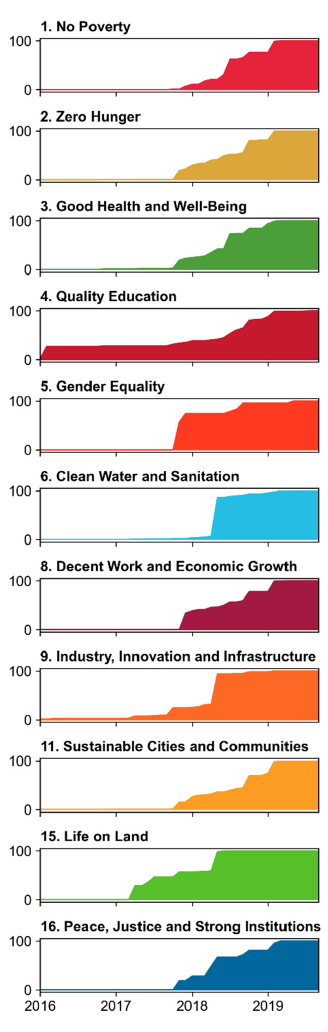
Figure 10. Cumulative timelines of V1 data creation dates across all 21,950 SDG-relevant OSM features. OSM data on SDG 5 (Gender Equality) were the most frequently edited, with a me- dian of six versions per feature compared to the typical median terminal version of two or three (Figure 11a). A small minority of OSM data on SDG 3 (Good Health and Well- Being), SDG 4 (Quality Education), and SDG 6 (Clean Water and Sanitation) were edited nine or more times, yielding at least Version 10 data. SDG 5 data were also edited over the longest period of time, with a median V1–Vn duration of 272 days (Figure 11b). SDG 9 (Industry, Innovation, and Infrastructure) data were also highly versioned over a long period of time (median duration: 242 days). Considering both the high number of versions and the long duration between feature creation and terminal versioning, SDG 5 data are the most appropriate for longer-term monitoring.